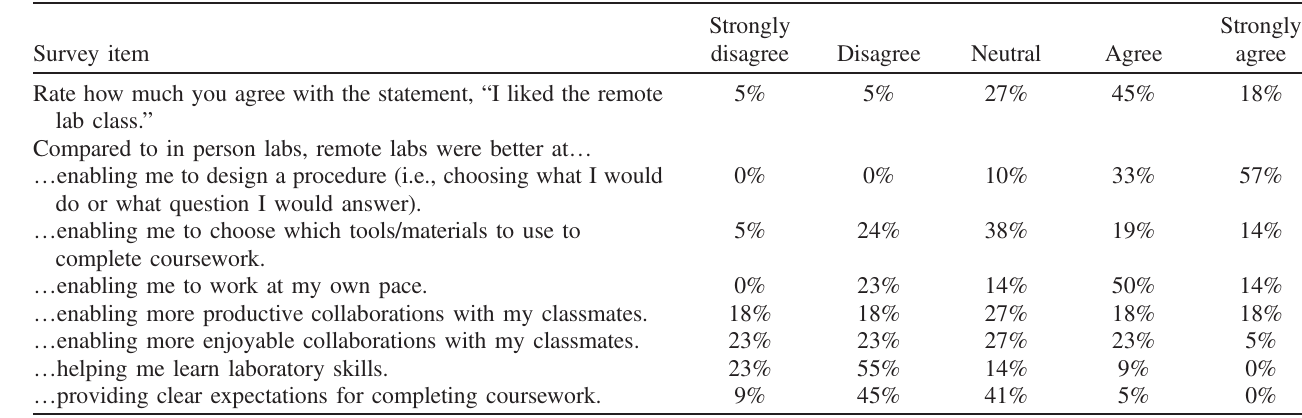
TABLE I. Responses to a subset of the Likert scale items about the remote lab course administered at the end of the E-CLASS. We present the percentage of students that answered each item with strongly disagree , disagree , neutral , agree , or strongly agree . N ¼ 22 , though some questions only had 21 responses. Numbers are rounded to the nearest